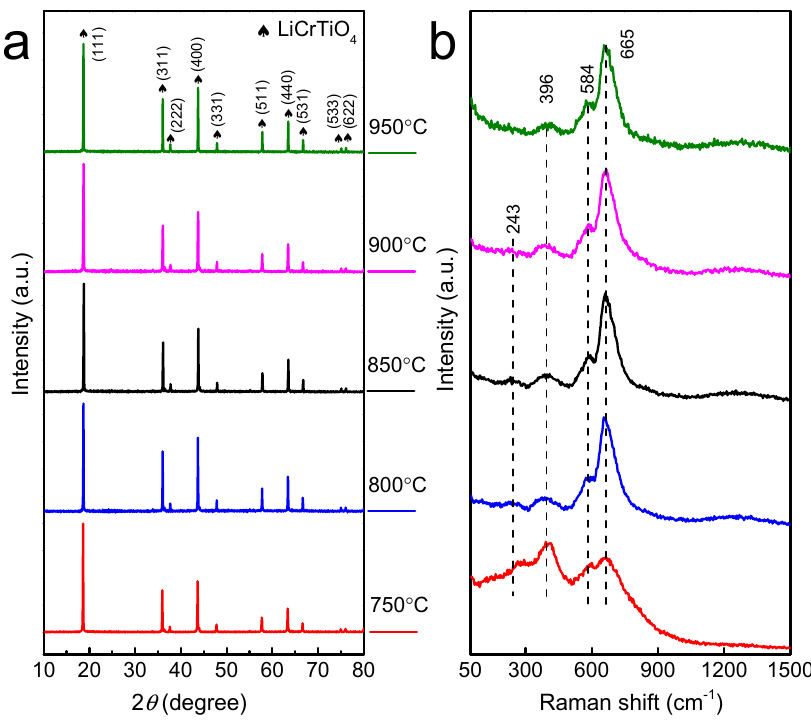
Figure 2. ( a ) The XRD (X-ray diffraction)patterns and ( b ) the Raman spectra of LiCrTiO 4 sintered in a powder form at a temperature of 750 °C (red), 800 °C (blue), 850 °C (black), 900 °C (magenta) and 950 °C (olive).